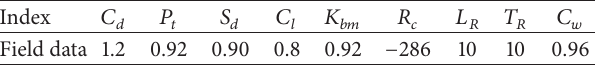
Table 7: Field data for durability evaluation of Nanping Bridge.